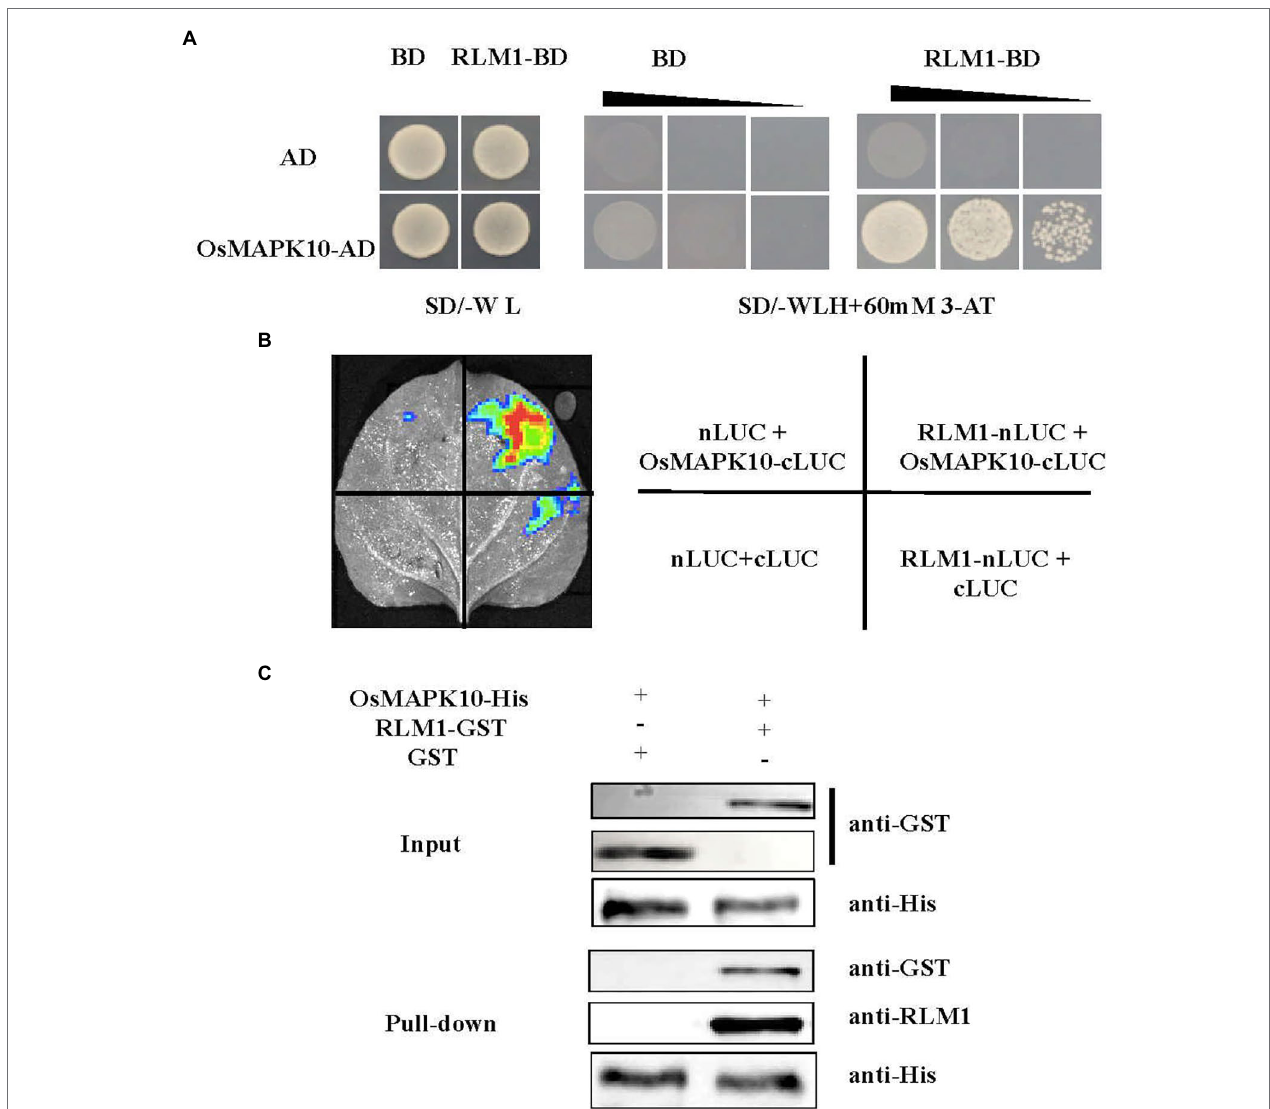
FIGURE 6 | RLM1 physically interacts with OsMAPK10. (A) A Y2H interaction assay was performed between RLM1 and OsMAPK10. A pGADT7 vector (AD) was used as the negative control. RLM1 was fused to the pGBKT7 vector (RLM1-BD). OsMAPK10 proteins were fused to the pGADT7 vector (OsMAPK10-AD). (B) The full OsMAPK10 protein was fused to the pCAMBIA1300-cLUC vector (OsMAPK10-cLUC). The full RLM1 protein was fused to pCAMBIA1300-nLUC (RLM1-nLUC). Split-LUC complementation assay showing that RLM1 can interact with OsMAPK10 in cells of N. benthamiana leaves. The LUC signals were not detected in the corresponding negative controls. (C) Pull-Down assays of RLM1 with OsMAPK10 in vitro . RLM1-GST was incubated together with OsMAPK10-His beads, and GST proteins were used as controls. Western bolt was detected via anti-GST, anti-RLM1, and anti-his antibodies, respectively. Compared with the input and Pull-Down band results, the results showed that GST did not interact with OsMAPK10, but RLM1 interacted with